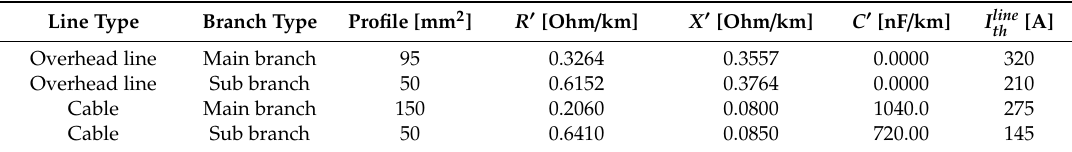
Table A1. Line parameters of LV